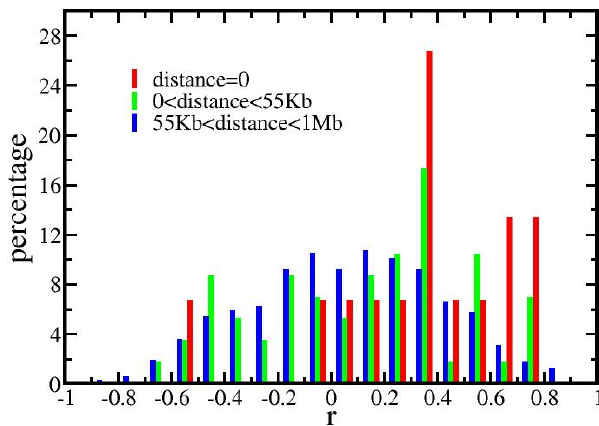
Figure 4. Distribution of correlations between miRNAs and proxi- mate mRNAs. This figure showed the distributions for 3 groups of miRNA-mRNA pairs, classified by the distance between a miRNA and an mRNA on the same chromosome. The y-axis shows the percentage of miRNA-mRNA pairs in each range of correlation ( 2 1 to 1 with binsize 0.1). An intronic miRNA had a distance zero to its host gene. The average length of a human gene, 55Kb (http://www.ncbi.nlm.nih.gov/ Web/Newsltr/Spring03/human.html), was chosen as one distance boundary. As the distance between the correlated pair increased, the distribution increasingly shifted away from positive correlations to